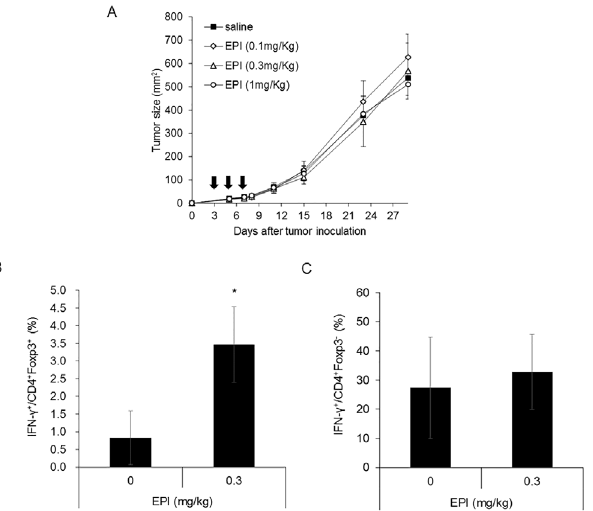
Fig 5. Epirubicin (EPI) might modulate immunosuppressive function of Tregs in vivo . (A) CMS5a tumor cells (1 x10 6 ) were injected (s.c.) in the right inguinal region of BALB/c mice (8 mice per group). Mice were treated with epirubicin (0.1, 0.3 or 1 mg/kg i.v. dosing on days 3, 5 and 7 as indicated by arrows) or saline, and tumor volume was measured at appropriate intervals until day 29. The data are shown as the mean ± SD (n = 4). (B) The percentage of IFN- γ -positive cells within the CD4 + FoxP3 + cell population. (C) The percentage of IFN- γ -positive cells within the CD4 + FoxP3 - cell population. On day 8, the mice treated with epirubicin or saline were euthanized and tumors were removed. Tumor-infiltrating lymphocytes dissociated from the pooled tumors were stained with anti-CD4, anti-CD8, anti-Foxp3 and anti-IFN- γ antibodies, and then analyzed by flow cytometry. Each column represents the mean ± SD (n = 3). Asterisks represent statistically significant differences as determined by Student ’ s t test ( * , p <